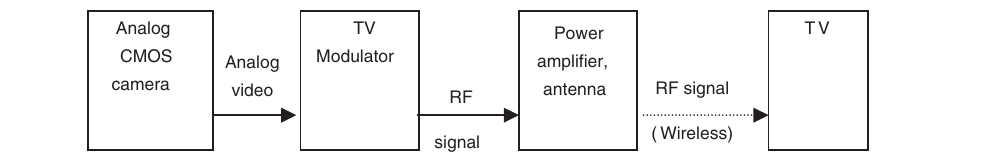
Figure 5 Block diagram of solution 1: analog camera + analog video transmission.